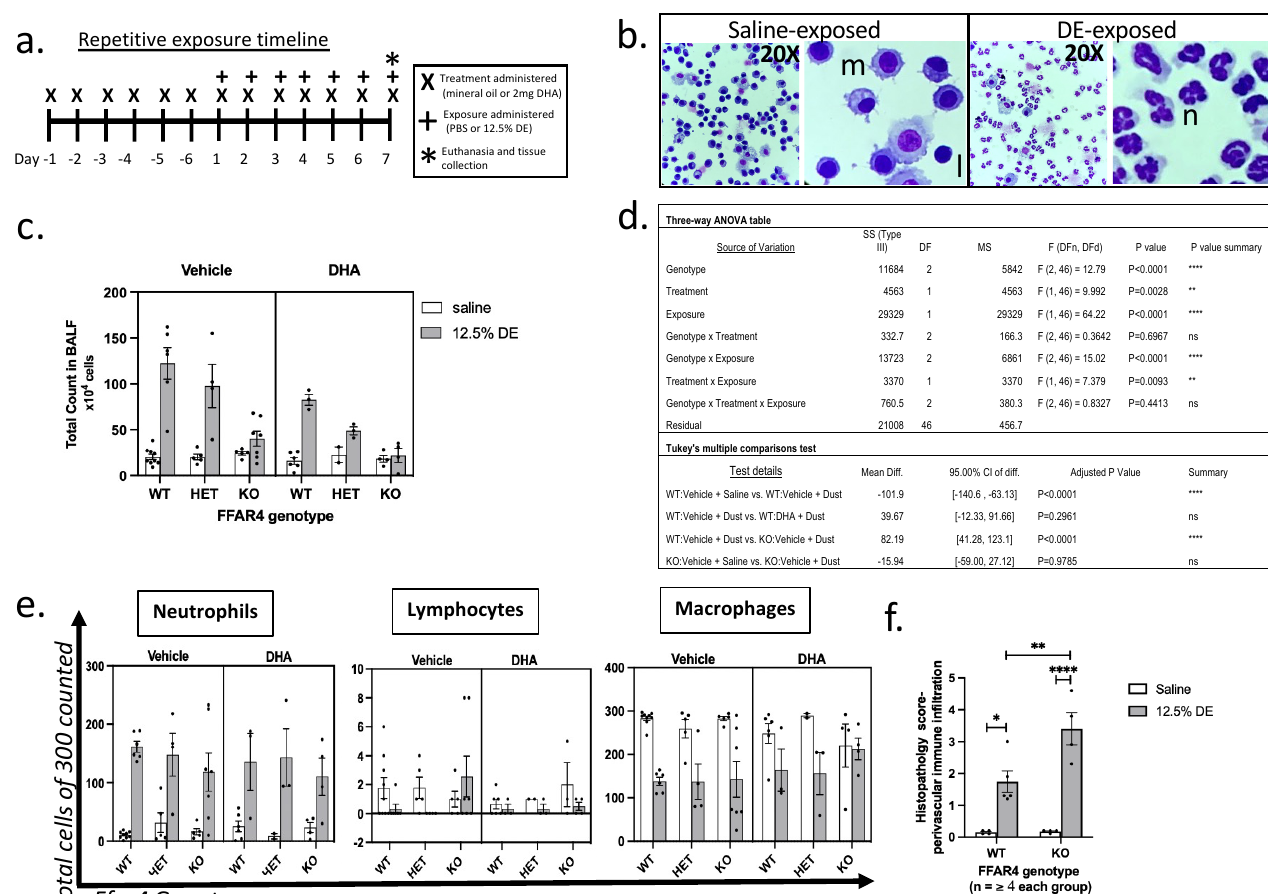
Figure 1. Significantly dampened immune recruitment in Ffar4 − / − following repetitive pulmonary dust exposure with no changes to cell populations. ( a ) A schematic of the experimental timeline of repetitive exposure with treatment. Mice were given a 6-day pre-treatment of mineral oil or DHA by oral gavage, followed by a 7-day concurrent treatment with exposure to saline or DE. Mice were euthanized 5 h after the final doses on day 7 of the exposure period. ( b ) Representative DiffQuick-stained cytospins of BAL cells for saline- and DE-exposed mice show macrophages (m) and neutrophils (n) in the airways (20 × and 40 × ). Repetitive DE exposure over 7 days significantly induces BALF cell influx in an exposure- and genotype-dependent manner ( c , d ). This influx is marked by neutrophilia in DiffQuick-stained- cytospins determined by cell differential analysis from masked samples ( e ). There were no significant changes in cell differentials between genotypes, though exposure induced neutrophilia (main effect of exposure: p < 0.0001). ( f ) H & E stained FFPE lung sections were masked and scored for vascular inflammation. Inflammation was induced by DE exposure in both WT and KO compared with their genotype-matched controls (Adj. p = 0.0127 and <0.0001 respectively). Ffar4 KO mice had significantly higher inflammatory scores than WT (Adj. p = 0.0095). Experiments were performed in triplicate (at minimum) with all groups represented in each separate experiment. * p < 0.05; ** p <